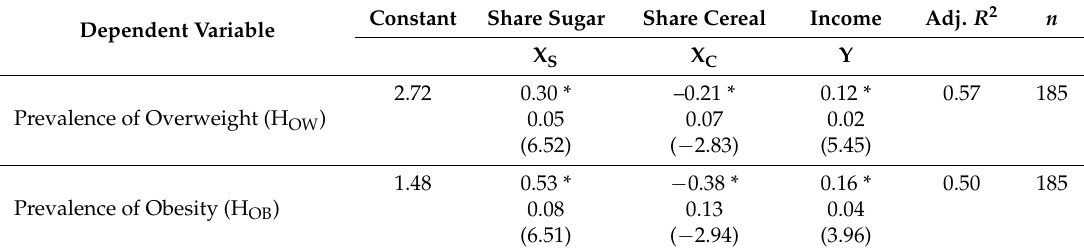
Table 2. Regression results: H OW and H OB regressed on X S , X C and Y (double-log